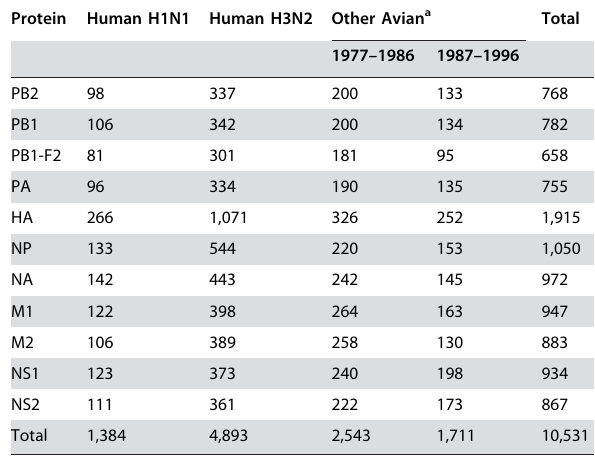
Protein Human H1N1 Human H3N2 Other Avian a